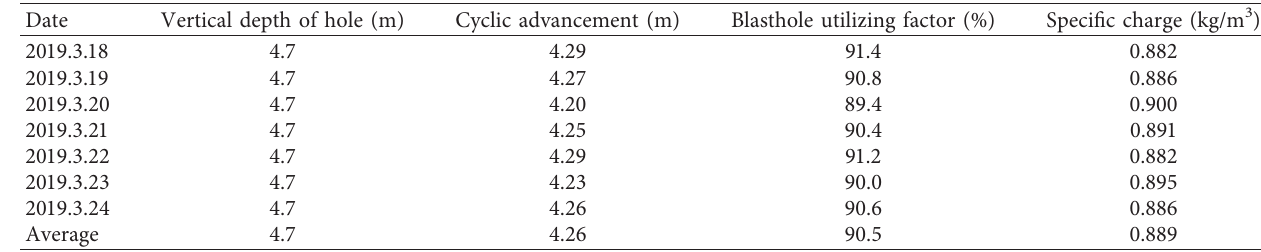
Table 9: Technical statistics of V-cut blasting with auxiliary holes.